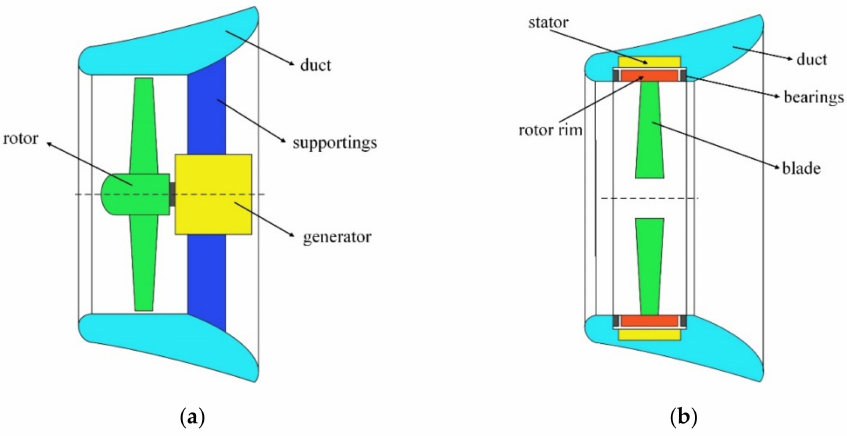
Figure 1. Structural comparison between a DT and a SDT: ( a ) DT; ( b )